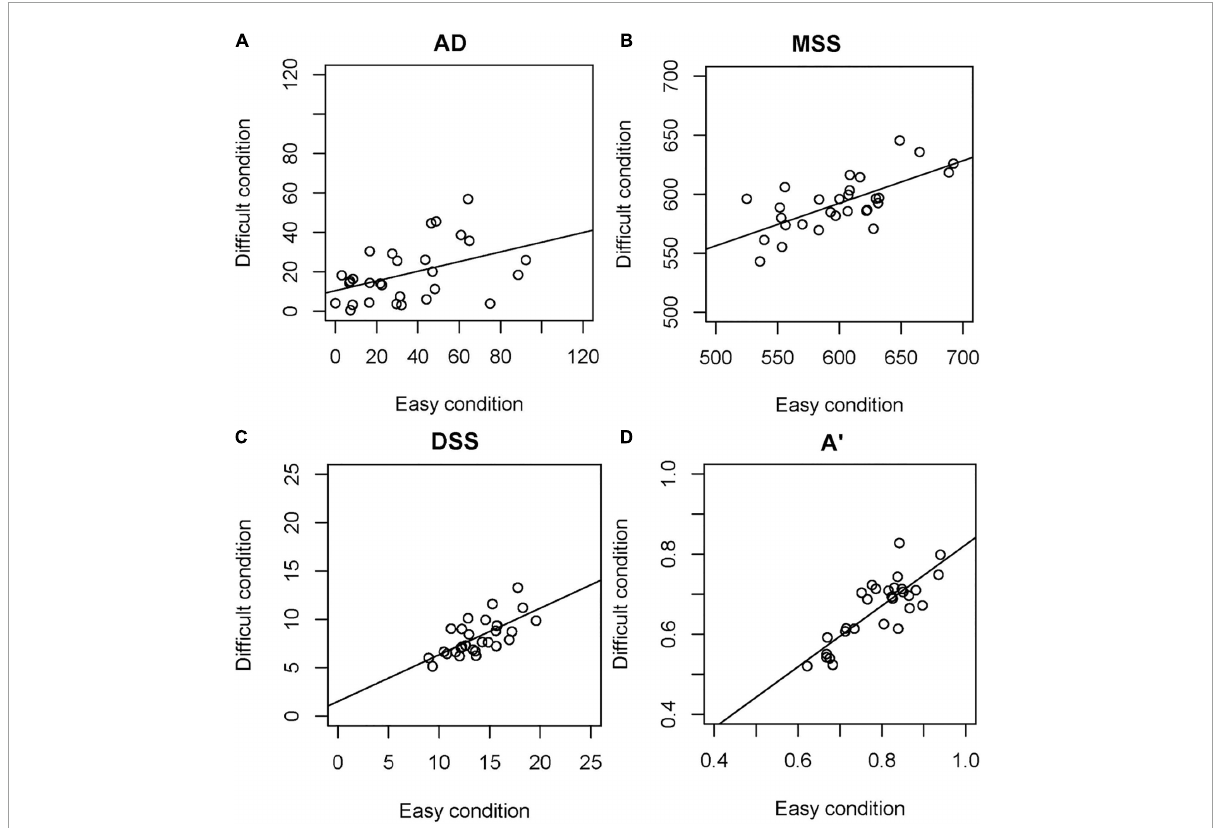
FIGURE4 Correlation between easy and difficult conditions. (A) AD, (B) MSS, (C) DSS, (D) A’ . AD, absolute difference between the real standard and mean of the subjective standard; MSS, mean of the subjective standard; DSS, dispersion of the subjective standard; A’ , sensitivity independent of the response criterion according to the signal detection